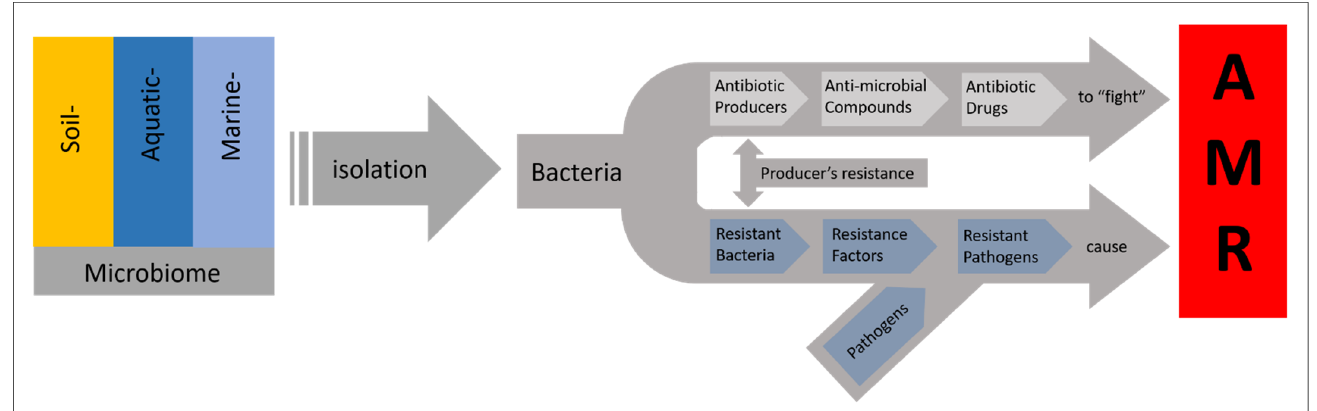
Figure 3. The dilemma of resistance against natural product-derived antibiotics. Antibiotic-producing bacteria exist in the same environments as antibiotic-resistant ones. Antibiotic resistance is also linked to antibiotic production by the respective producers’ resistance for “self-protection”. The resistance factors available within the environment finally contribute to the a nti m icrobial r esistance (AMR) of clinically relevant pathogens.